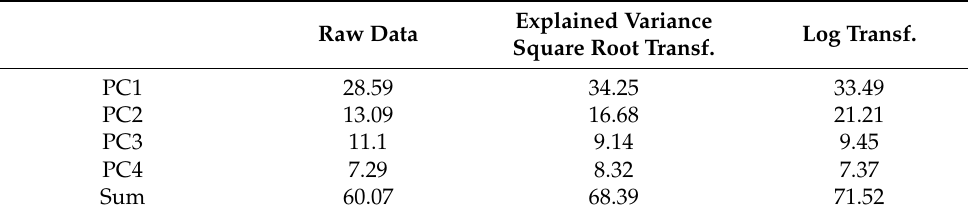
Table 2. Variance explained by the main factorial axes (PCs) for 3 data-conditioning mode. Raw Data